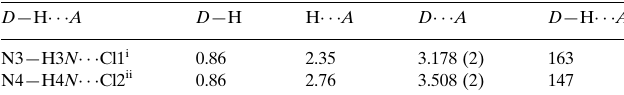
Hydrogen-bond geometry (A˚ , (cid:2)